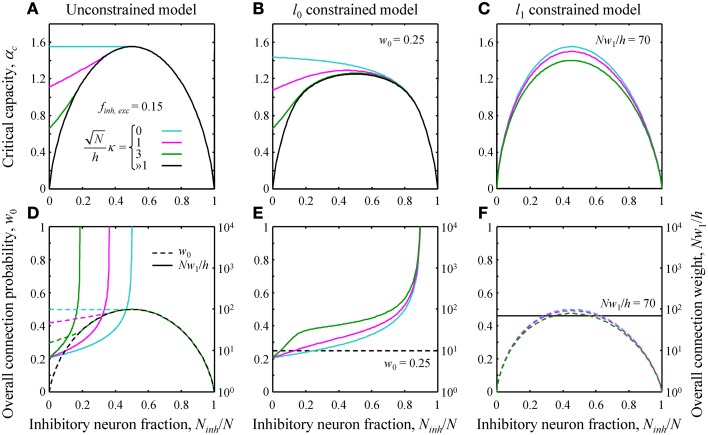
(A–C) Critical capacity as a function of the fraction of potential inhibitory inputs for finh = fexc = 0.15 and various values of the robustness parameter κ. (A) The unconstrained model. At certain values of Ninh/N, the curves merge with the asymptotic solution (black curve) corresponding to the limit of large robustness, Nκ/h≫1. For smaller fractions of inhibitory inputs, the critical capacity is a decreasing function of κ and an increasing function of Ninh/N. (B) Qualitatively similar results were obtained in the l0 constrained model. (C) In the l1 constrained model the critical capacity curves are slightly skewed to the left and have a maximum at Ninh/N < 0.5 for all values of κ. Values of the constraints are w0 = 0.25 in B and Nw1/h = 70 in (C). (D–F) Overall connection probability (dashed lines) and overall connection weight (solid lines) as a function of Ninh/N. Note the different y-axis scales for w0 (linear, left) and Nw1/h (logarithmic, right). In the constrained models, the overall connection probability (E) or the overall connection weight (F) is fixed for all values of Ninh/N (horizontal lines).